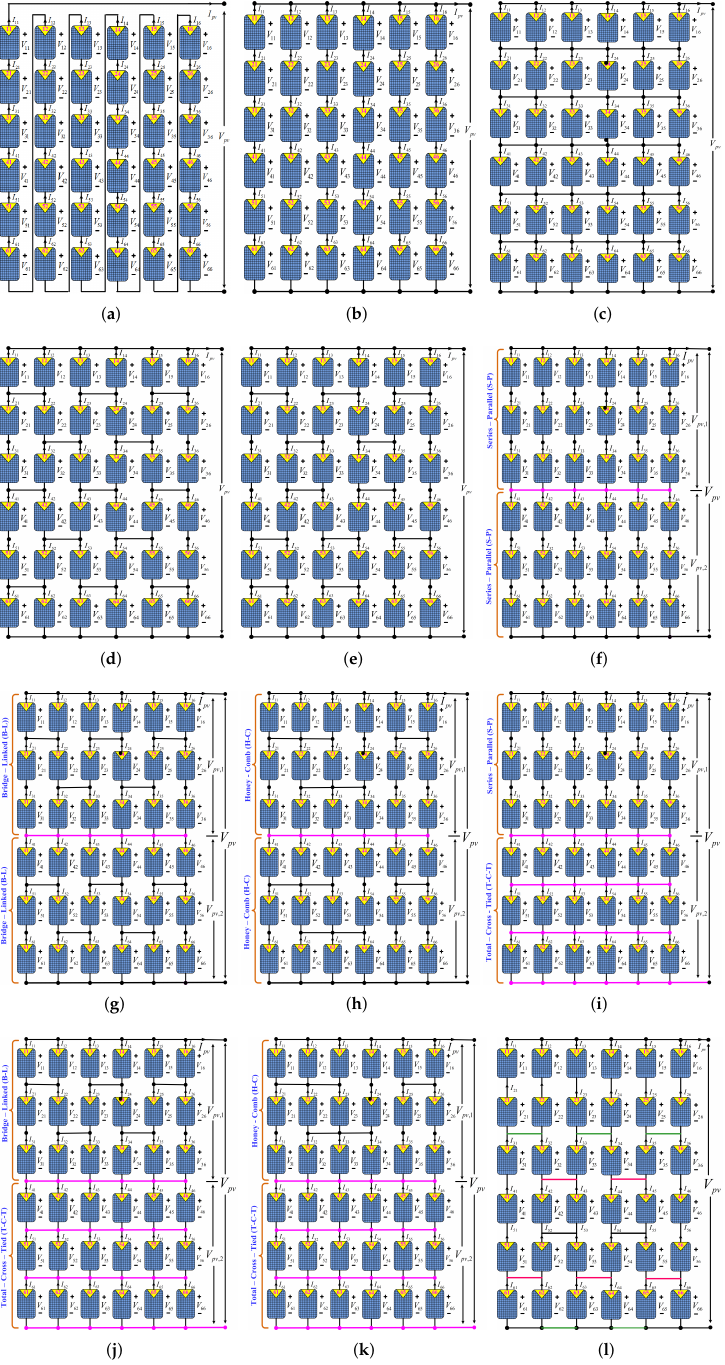
Figure 3. Conventional & proposed hybrid topologies. (a) Simple-Series (S-S), (b) Series-Parallel (S-P), (c) Total-Cross-Tied (T-C-T), (d) Bridge-Linked (B-L), (e) Honey-Comb (H-C), (f) Series-Parallel-Cross-Tied (S-P-C-T), (g) Bridge-Linked-Cross-Tied (B-L-C-T), (h) Honey-Comb-Cross-Tied (H-C-C-T), (i) Series-Parallel-Total-Cross-Tied (S-P-T-C-T), (j) Bridge-Linked-Total-Cross-Tied (B-L-T-C-T), (k) Honey-Comb-Total-Cross-Tied (H-C-T-C-T), and (l) Bridge-Linked-Honey-Comb (B-L-H-C).